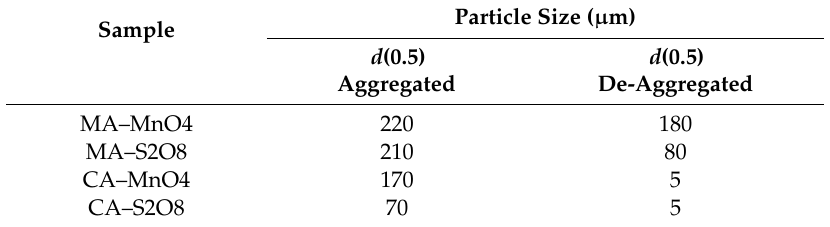
Table5. The d (0.5)valuesin µ moftheparticlesizedistributionoftheaggregatedandde-aggregatedsamples.